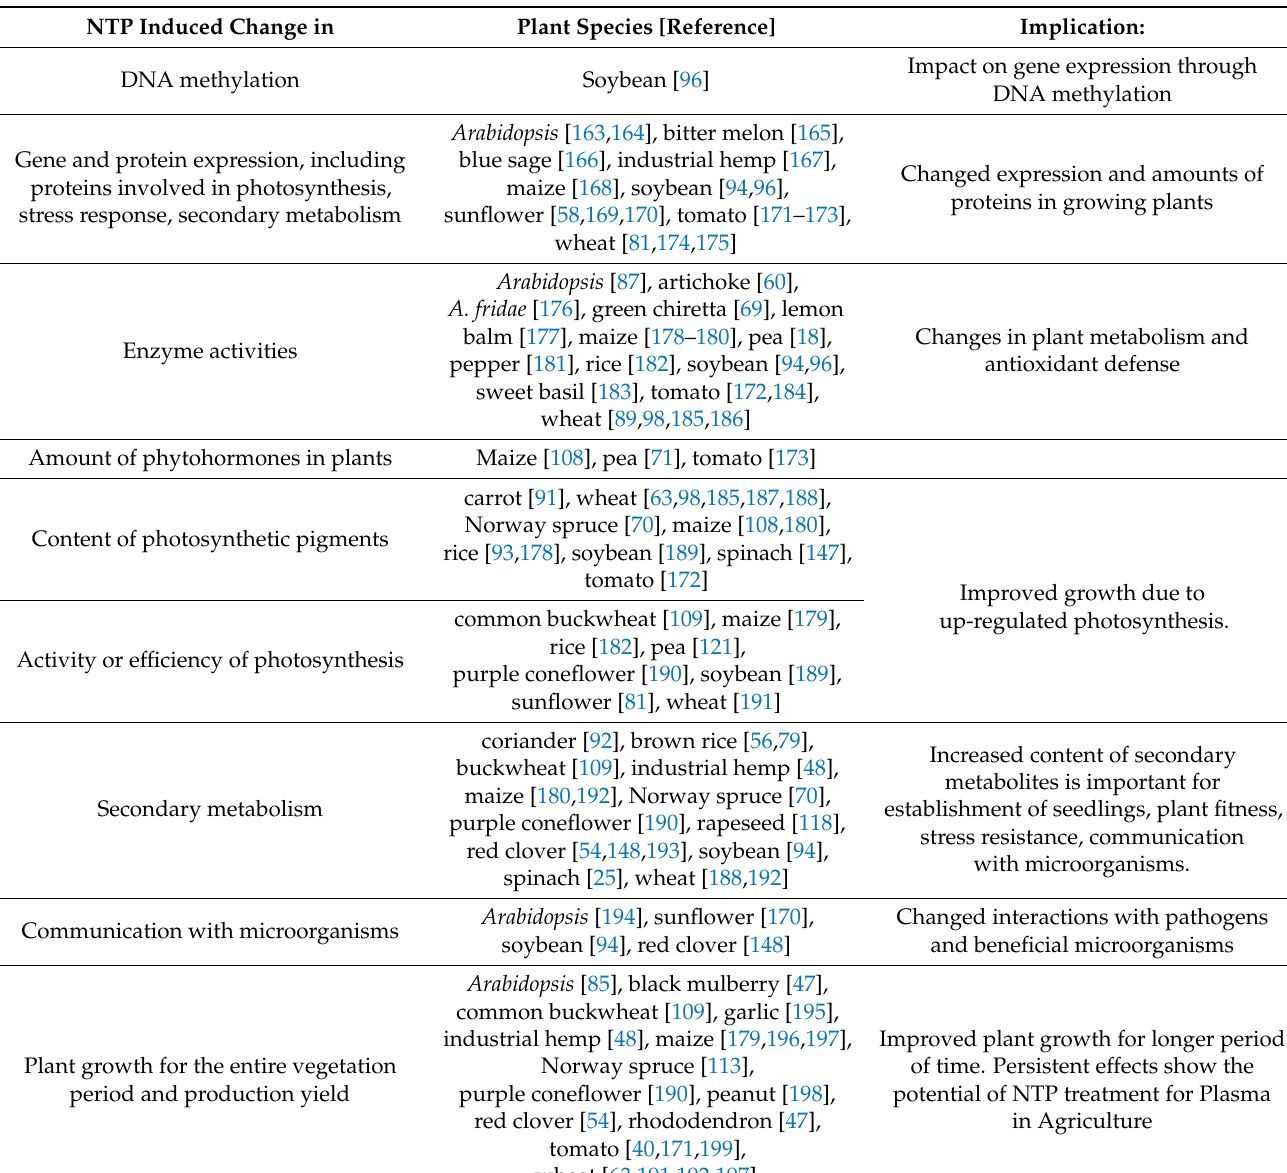
Table 4. Summary of published findings of NTP-induced biochemical changes in growing seedlings and